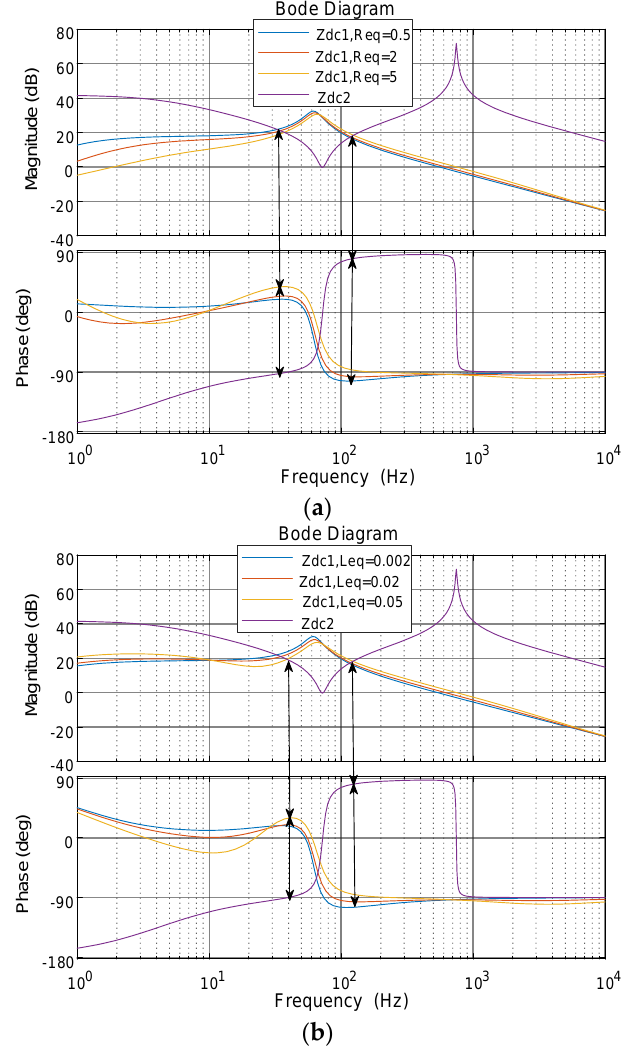
Figure 9. Impedance frequency responses of Z dc 1 and Z dc 2 under different equivalent virtual impedance values ( a ) R eq and ( b ) L eq .